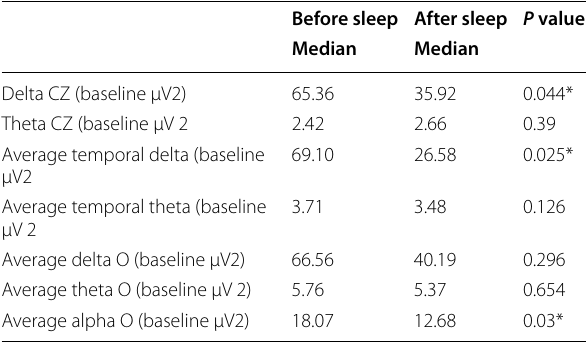
Table 3 Comparing QEE G before and after sleep in the cases group